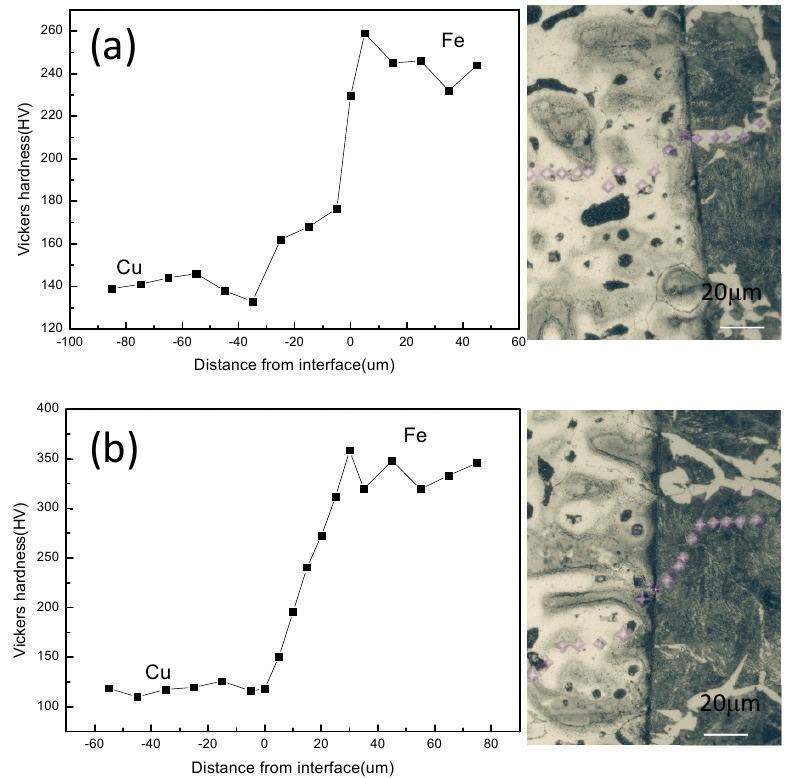
Figure 11. Micro-hardness and test indentations at the interfaces of the steel/copper bimetals: ( a ) ferrite/copper interface and ( b ) pearlite/copper interface.